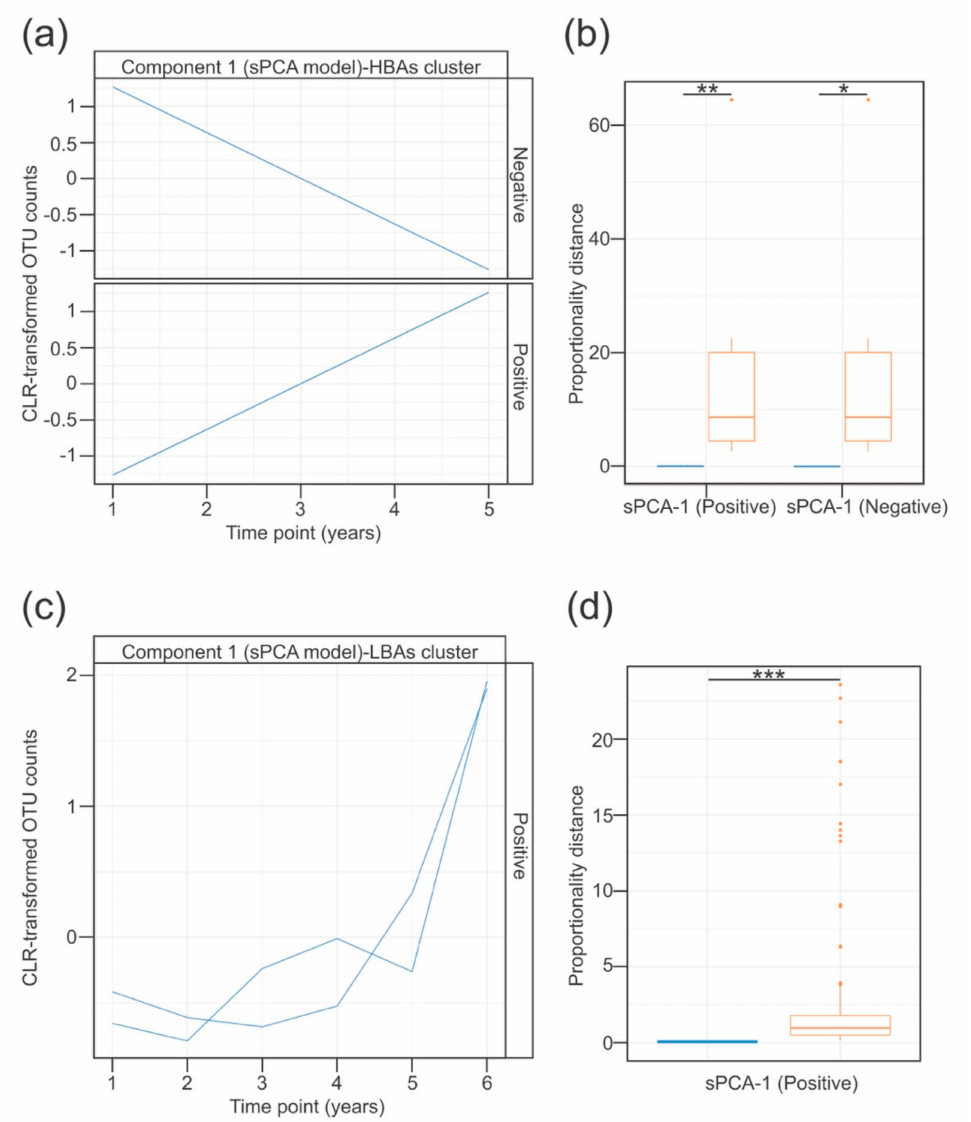
Figure 3. Longitudinal modelling of the BALF-associated microbial profiles in patients clustered based on BA detection patterns. ( a – d ) Temporal profiles of the OTUs grouped using sPCA in the HBA (A) or LBA (C) patient clusters. Blue traces represent the modelled abundance (Centred Log Ratio (CLR)-transformed) of the OTUs selected in the sPCA model across time. Within each component, the selected OTU profiles were subclustered into positive or negative according to the direction of the correlation between each OTU profile, and the indicated latent variable of the sPCA model. ( b , d ) Association between the features assigned to the same cluster was evaluated using proportionality distances. Bar plot in ( b ) (for the HBA subset) shows the proportionality distance of features from the same cluster (blue), and the distance of OTUs inside that cluster with every feature in the other cluster (orange). Given that only one cluster was selected in the LBA group, the bar plot in ( d ) represents the proportionality distance between pairs of features from the cluster (blue), and between each feature in that cluster and the rest of features in the entire dataset (orange). In both cases, the intra-cluster distance was significantly lower than the distance outside the cluster, suggesting a strong association between the selected OTU profiles clustered together. *, p < 0.05; **, p < 0.01; ***, p < 0.001 in the context of the Wilcoxon test. Type I error rate was controlled with the false discovery rate